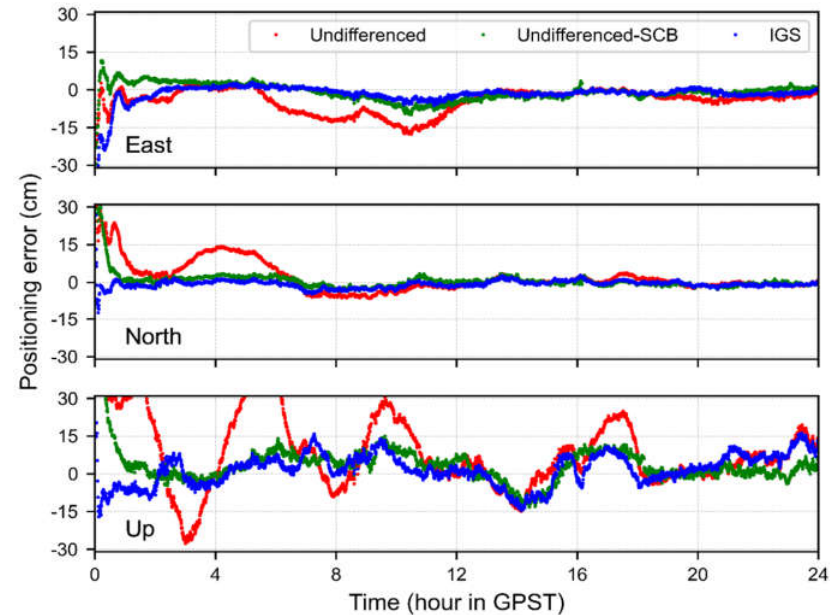
Figure 11. Time series of the positioning errors using different satellite clocks for station ABPO on DOY 031.